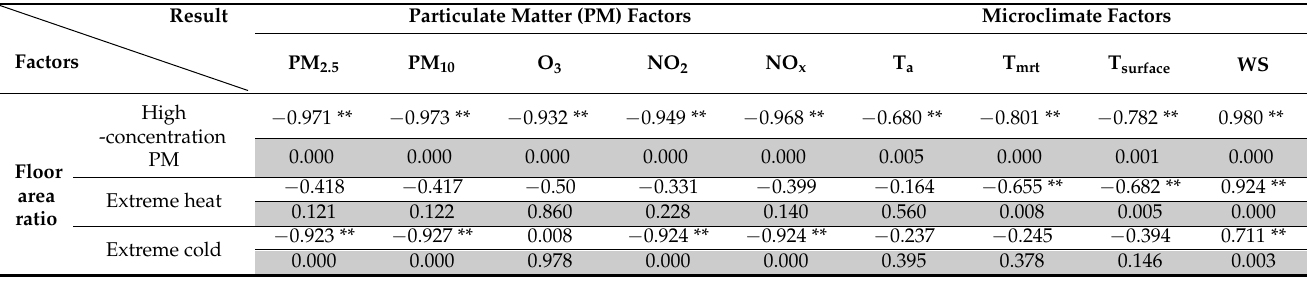
Table 3. Effects of floor area ratio on microclimate and air quality.